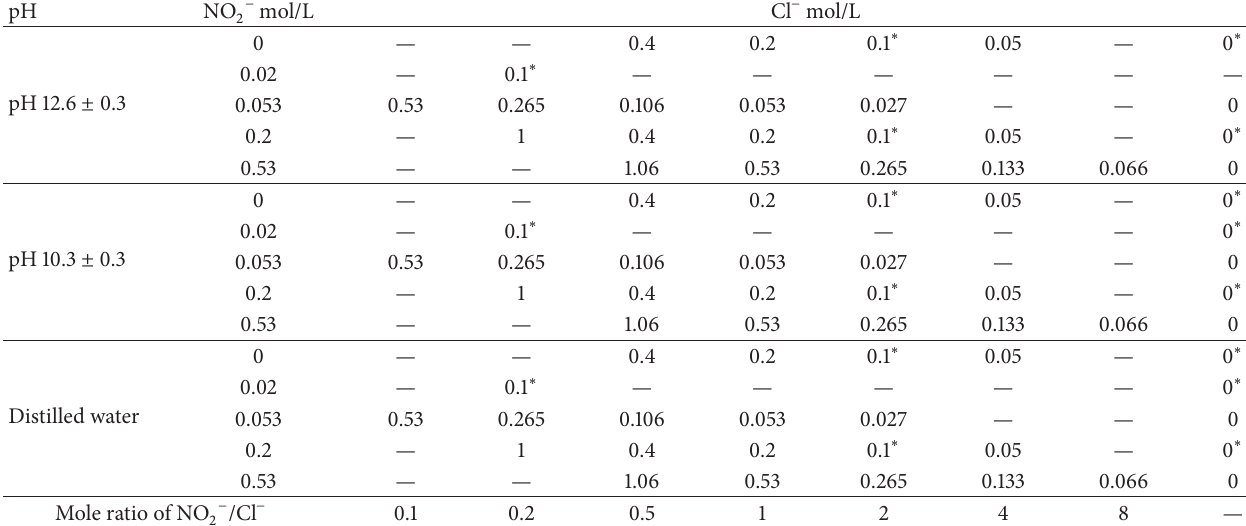
Table 1: Experimental design for chloride-induced corrosion.